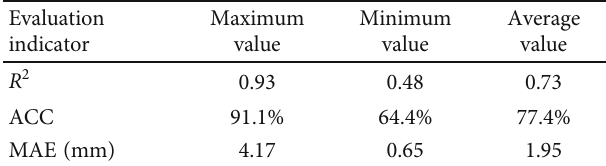
Table 4: Performance evaluation of prediction results of 70